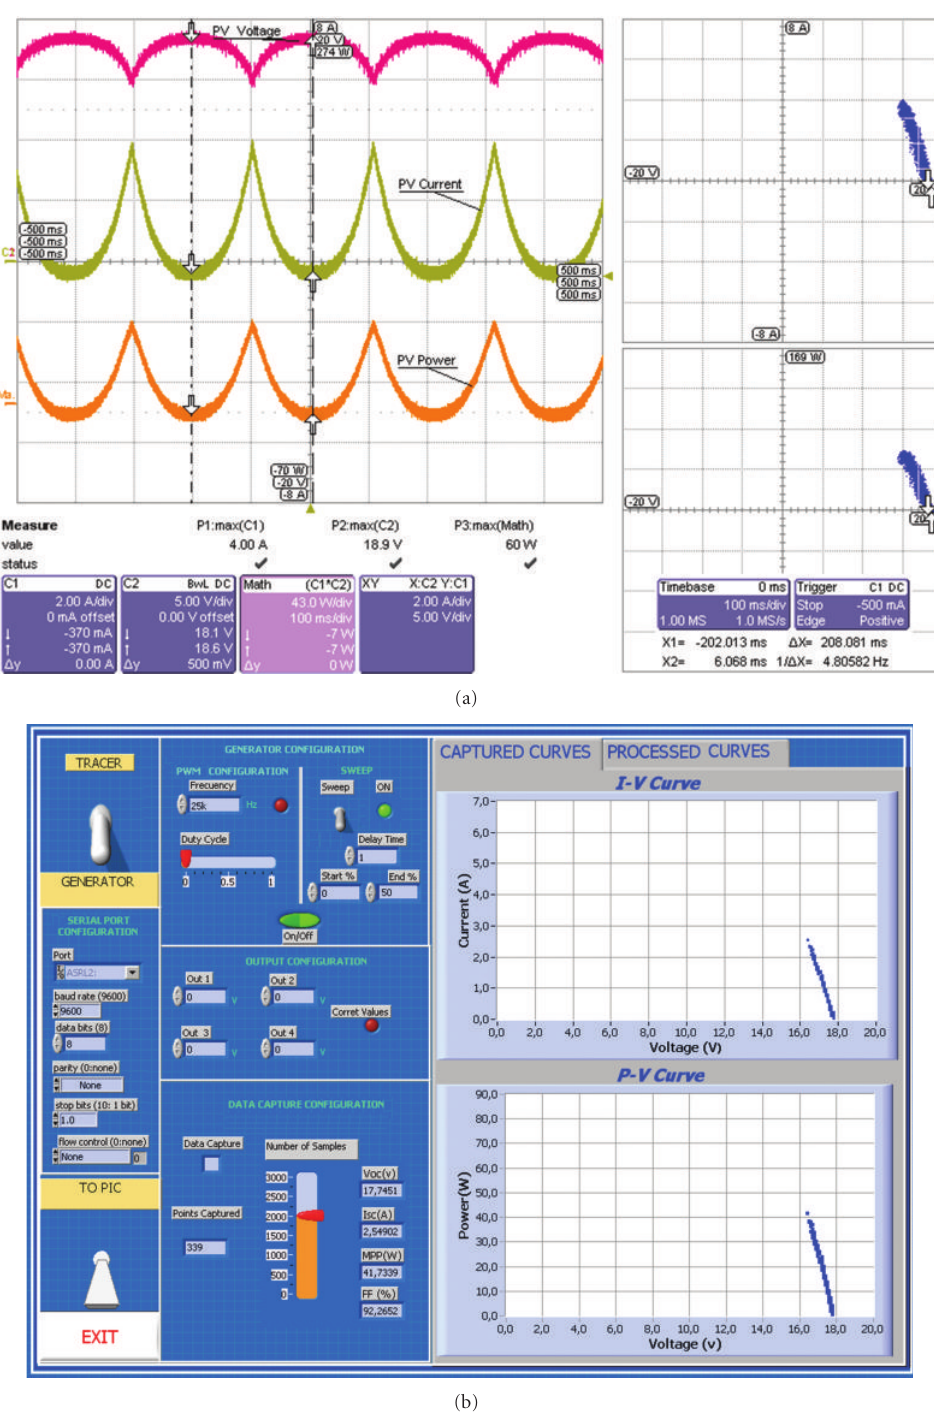
Figure 7: (a) Current (Channel C1: 2 A/div, 100 ms/div), voltage (Channel C2: 5 V/div, 100ms/div), and power (Math C1 ∗ C2: 43 W/div, 100ms/div) measurement. XY representation. (b) I-V and P-V curves obtained by means of the proposed system. DCS from 0 to